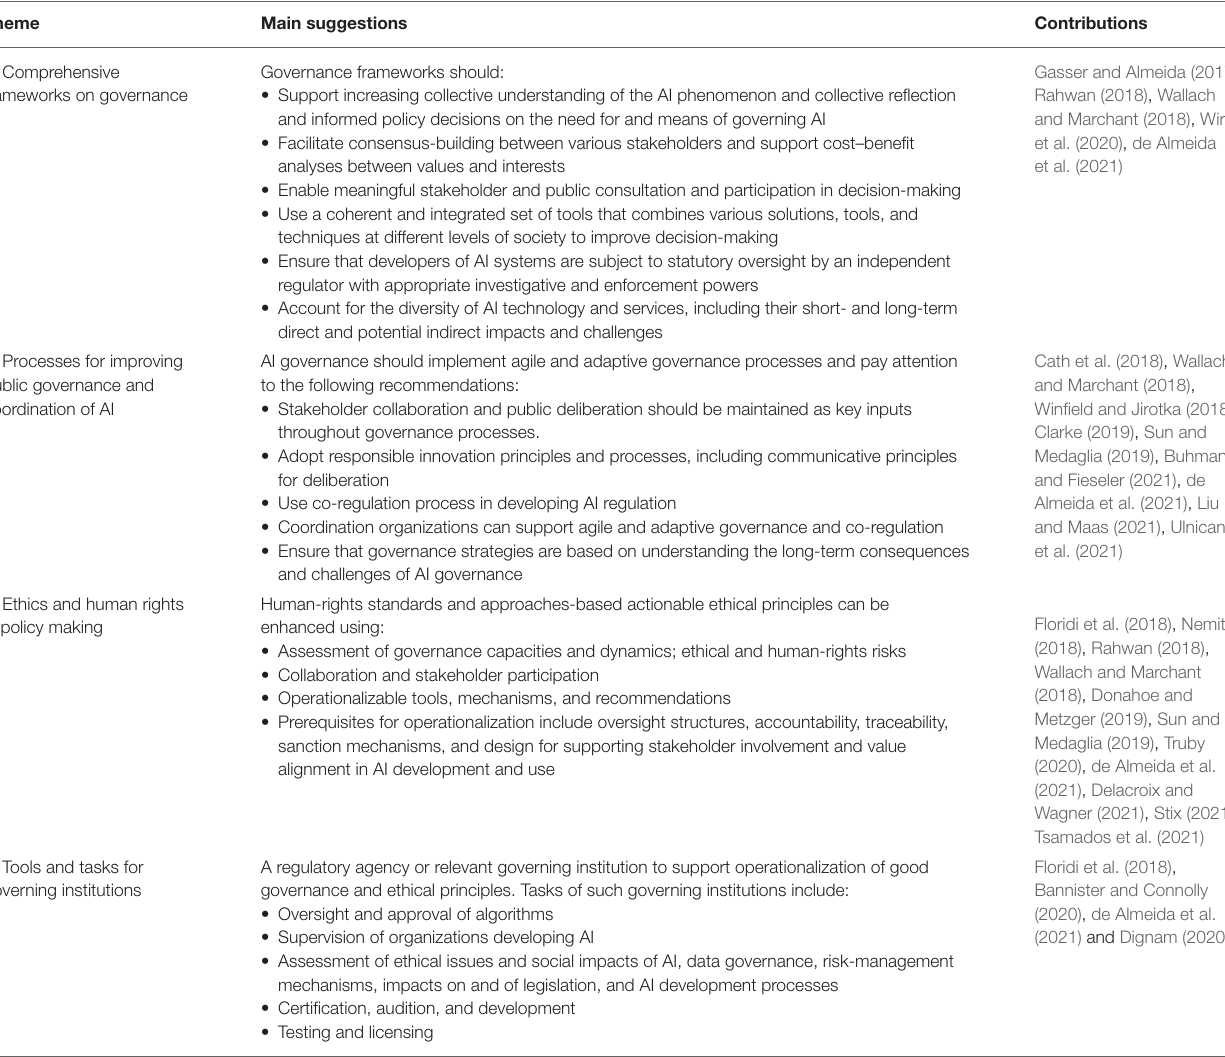
TABLE 2 | Overview of suggestions to improve and develop governance of